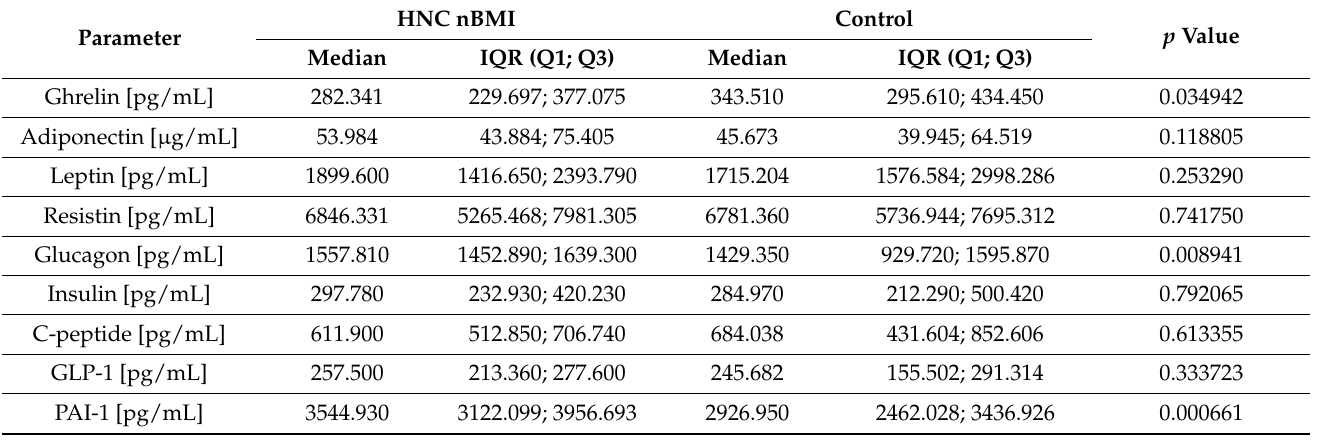
Table 5. Biochemical parameters with a statistically non-parametric distribution analyzed in head and neck cancer (HNC) patients with normal body mass index values (nBMI) and a control